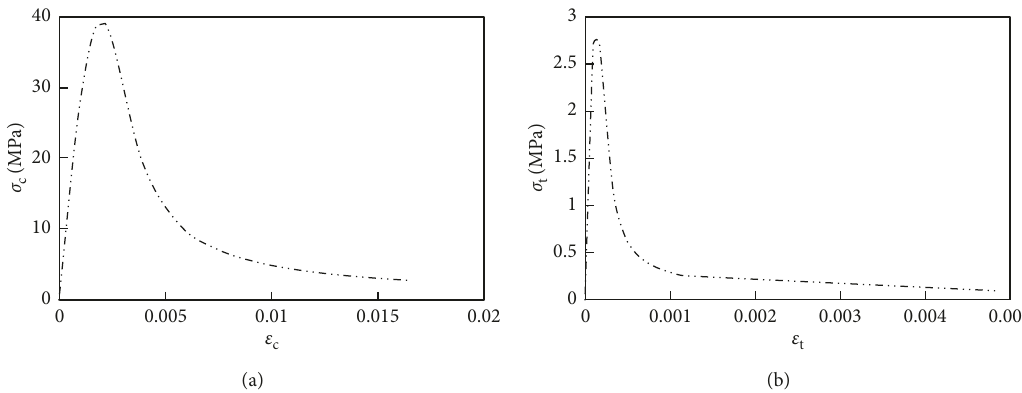
Figure 6: Concrete uniaxial constitutive curve. (a) Compression constitutive relation curves. (b) Tensile constitutive relation curves.